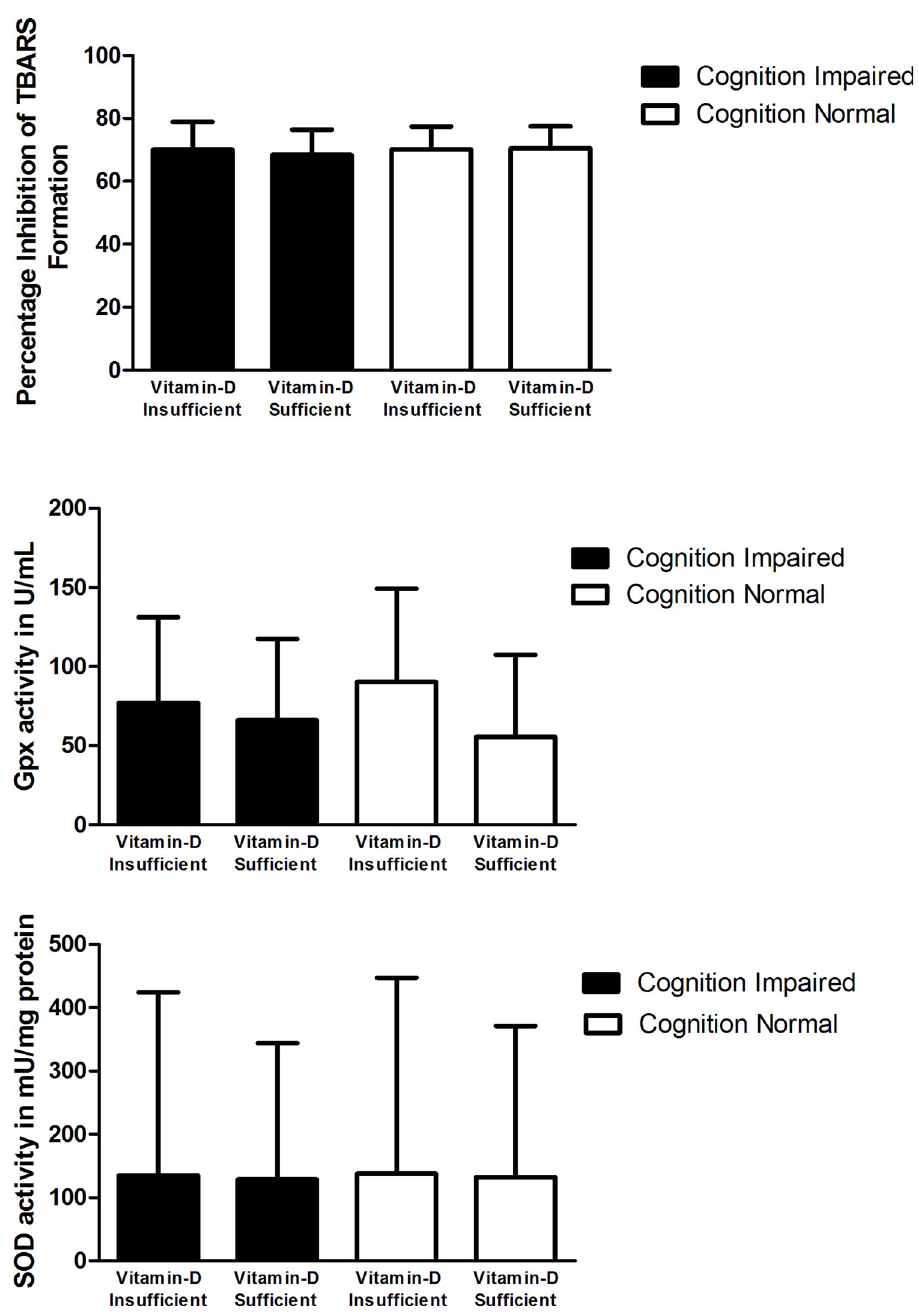
Fig 4. A. Comparison of total antioxidant activity by TBARS in diabetic subjects with vitamin-D and cognition status, B. Comparison of glutathione peroxidase (Gpx) activity in diabetic subjects with vitamin-D and cognition status, C. Comparison of superoxide dismutase (SOD) activity in diabetic subjects with vitamin-D and cognition status.